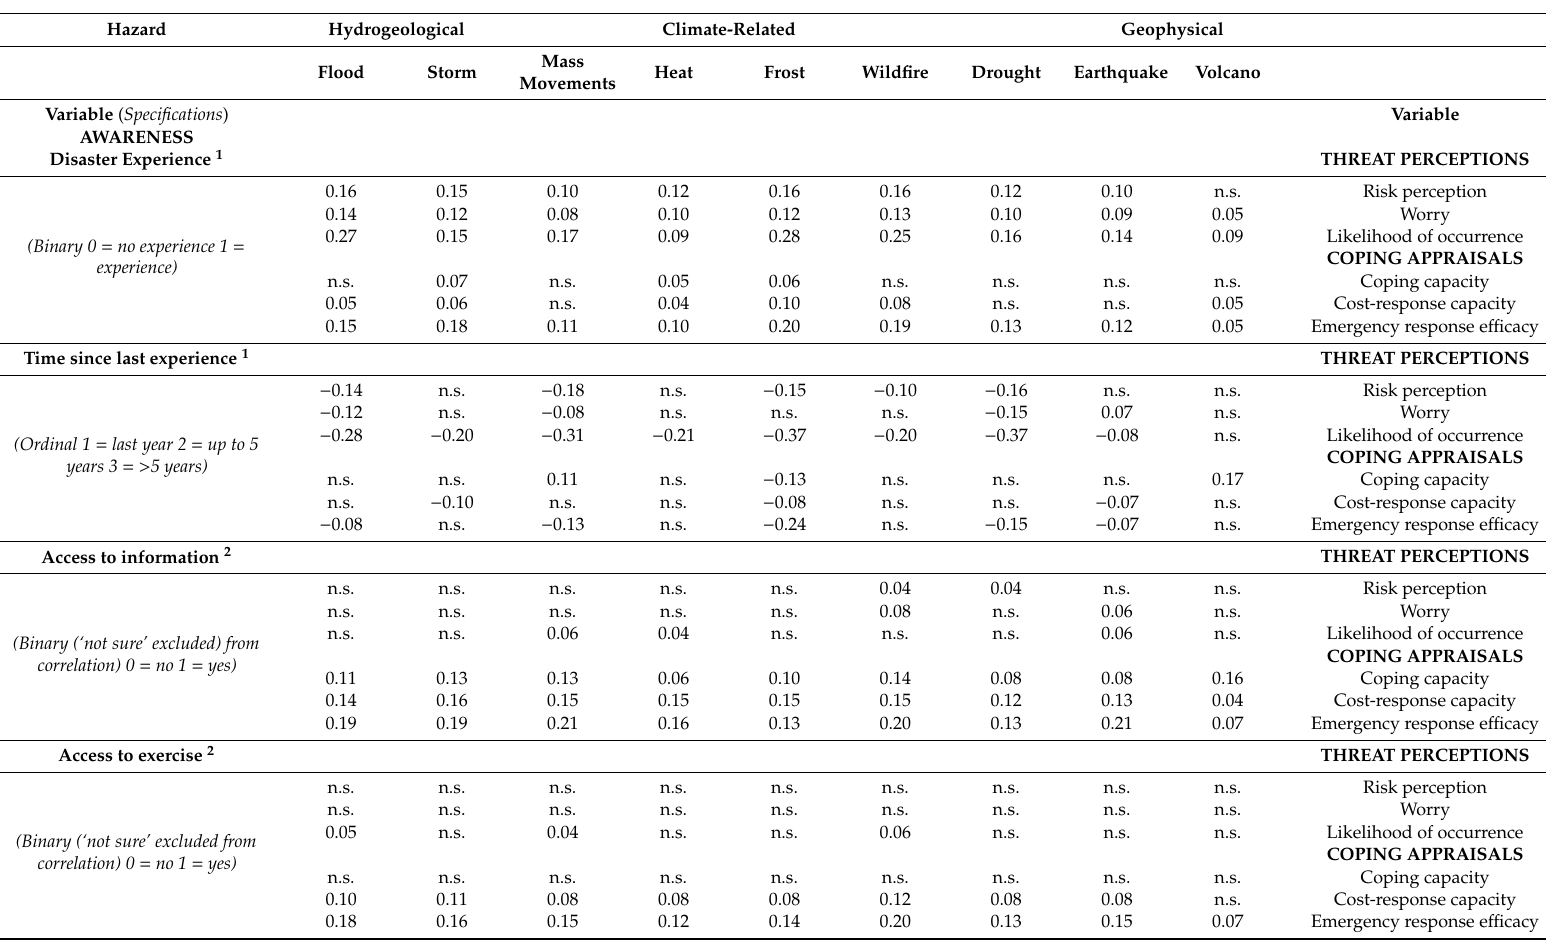
Table A1. Correlations (Spearman’s rho coe ffi cient) between awareness / confidence / demographic variables and threat perceptions / coping appraisals, per hazard. Hazard